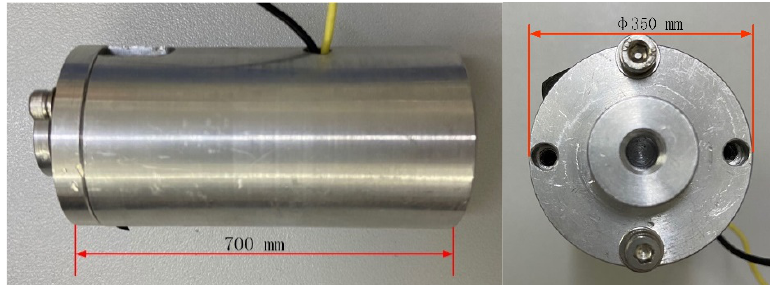
Figure 2. The prototype of the piezoelectric sensor-actuator. Table 1. The parameters of the PZT.